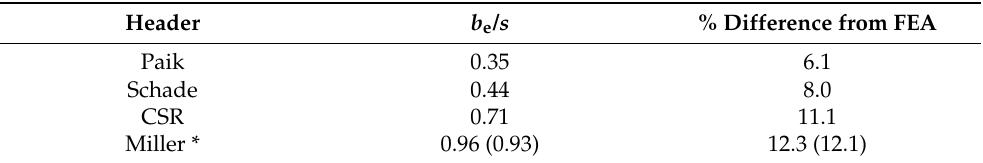
Table 2. Assessment of the effective width solution with respect to the FEA maximum normal stress for the panel taken from the bottom area of the ship. In Miller’s solution the out of parenthesis corresponds at the uniaxial E * and within parenthesis at the biaxial E *. Header b e / s % Difference from FEA